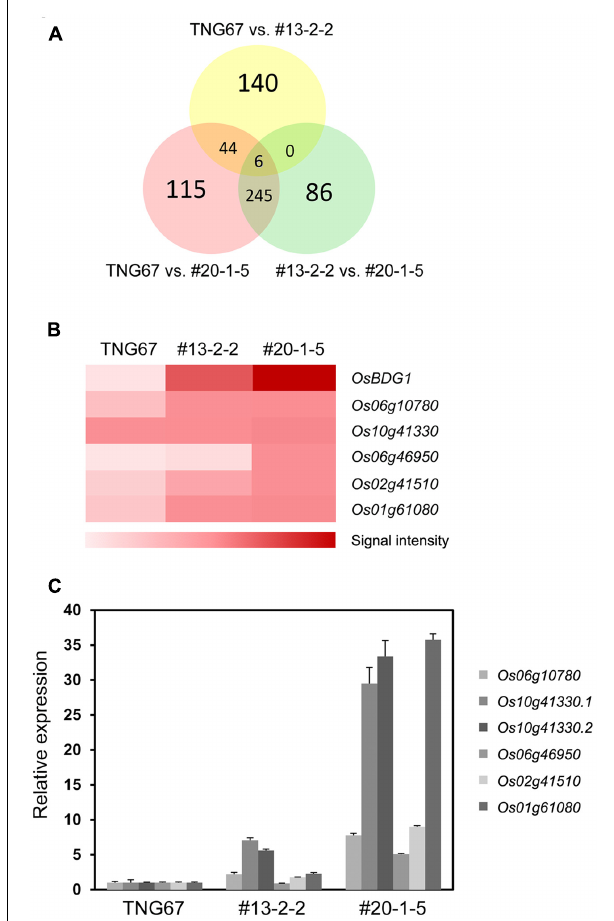
FIGURE 5 | Identification of downstream genes of OsBDG1 acting in the lamina joint. (A) A Venn diagram showing numbers of genes upregulated by OsBDG1 in each comparison. Two independent T3 transgenic lines for p OsBUL1 : OsBDG1 , #13-2-2 and #20-1-5 were selected as mild and strong expressers of OsBDG1 in collars, respectively, as shown in Figure 4C . (B) A heat map generated by microarray hybridization shows expression level of the five candidate genes identified as being gradually increased by OsBDG1 expression. Color scale represents log signal values. (C) Verification of the expression level on each candidate gene in the collar of WT and transgenic lines, #13-2-2 and #20-1-5 by quantitative RT-PCR. Os10g41330 is known to produce two putative transcripts, Os10g41330.1 and Os10g41330.2 by alternative splicing ( Supplementary Figure S1 ). Data are the average of three or four independent experiments and normalized by OsUBQ . Error bars indicate SD.